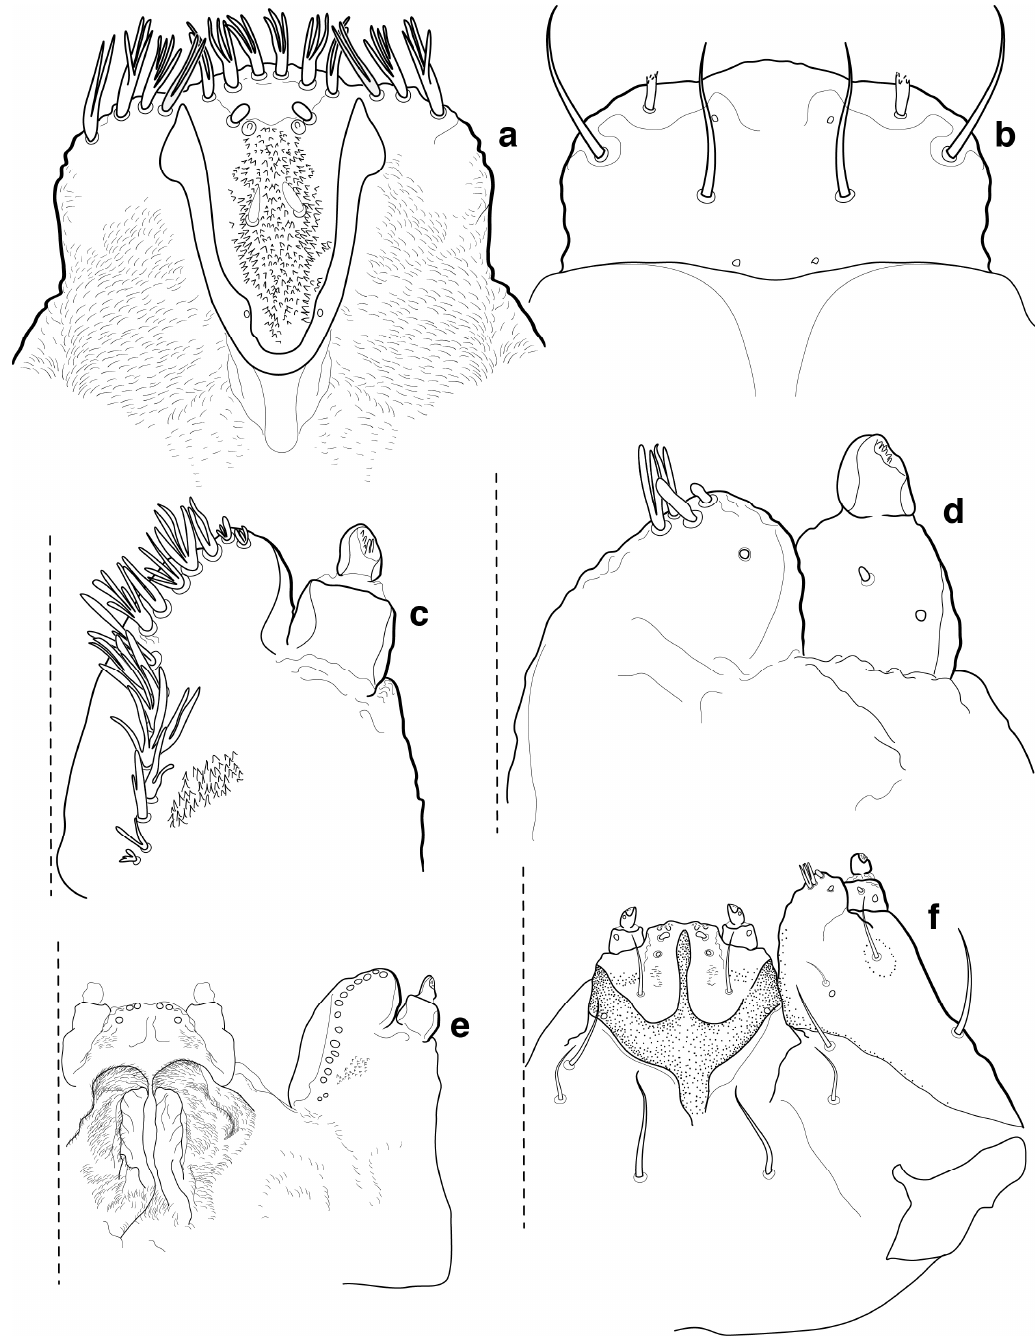
Figure 81. Sipalinus gigas mouthparts: ( a ) epipharynx; ( b ) clypeus (incomplete) and labrum; ( c ) detail, mala and maxillary palp, dorsal view; ( d ) mala and maxillary palp, ventral view; ( e ) labio-maxillary complex, dorsal view; and ( g ) labio-maxillary complex, ventral view ( lms2 : labial setae 2 broken).